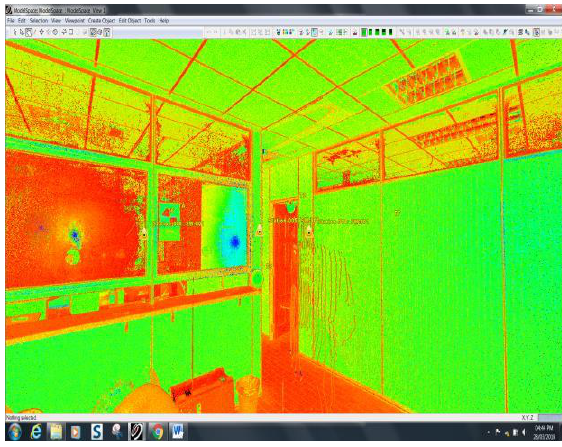
Figure 6: TLS data registration